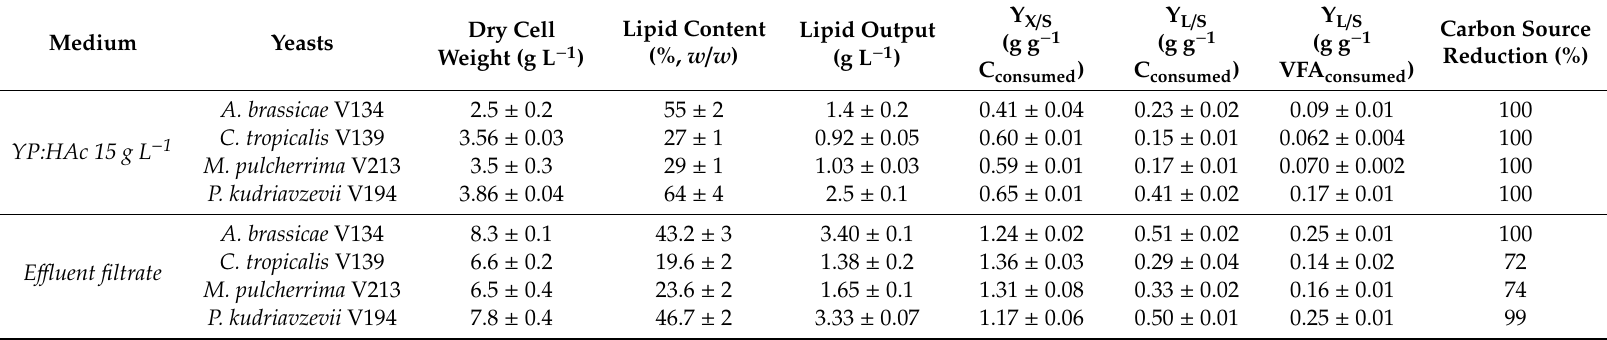
Table 2. Biomass, lipid production, and carbon source utilization by the four selected yeast isolates in YP:HAc 15 g L − 1 and in e ffl uent filtrate, after 120 h of cultivation.